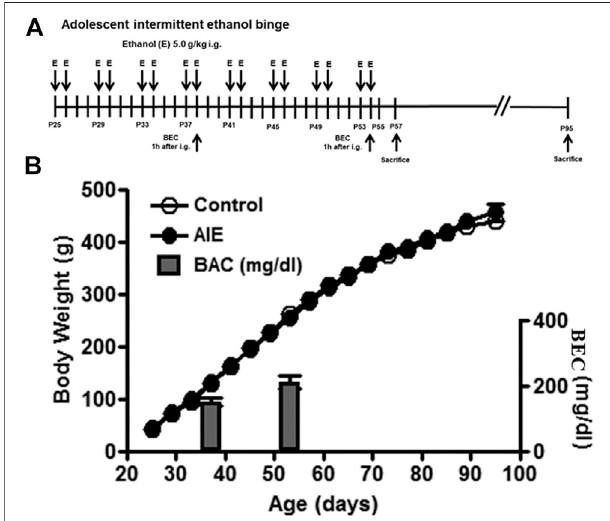
FIGURE 1 | Experimental design, body weights and blood ethanol concentration (BEC). (A) The timeline of the experimental design. Adolescent intermittent ethanol (AIE) started at postnatal day (P)25. Adolescent animals were intermittently administered with either water or ethanol (5 g/kg, 25% ethanol w/v, intragastric) with 2 days on and 2 days off during adolescence (P25 – P54). (B) Body weight was measured every four days during the procedure. There was no difference in the mean body weight betweencontrolandethanolgroupsfromP25toP95.BECwasmeasured1 h after treating with ethanol (5 g/kg, intragastric) at P38 and